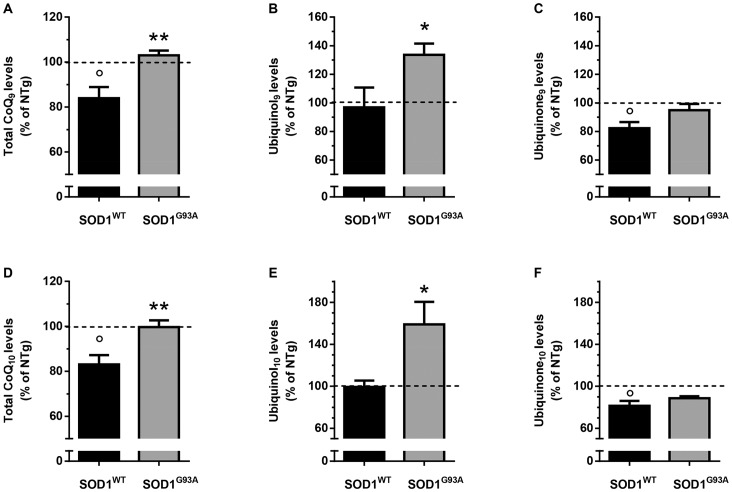
Increased levels of ubiquinol9/10 in the lumbar spinal cord of symptomatic SOD1G93A mice.Endogenous levels of CoQ9 (A–C) and CoQ10 (D–F) in the lumbar spinal cord of male 16 week-old 129Sv SOD1WT and SOD1G93A mice are shown as percentage of the levels measured in age-matched 129Sv non-transgenic mice (absolute values in table S1). Panels A, D show the total CoQs levels, whereas panels B, E and panels C, F show the reduced and oxidized forms, respectively. Each value is mean±SEM of 4–7 mice. * P<0.05, ** P<0.01 compared to SOD1WT mice; ° P<0.05 compared to 129Sv NTg mice (Student’s T-test).